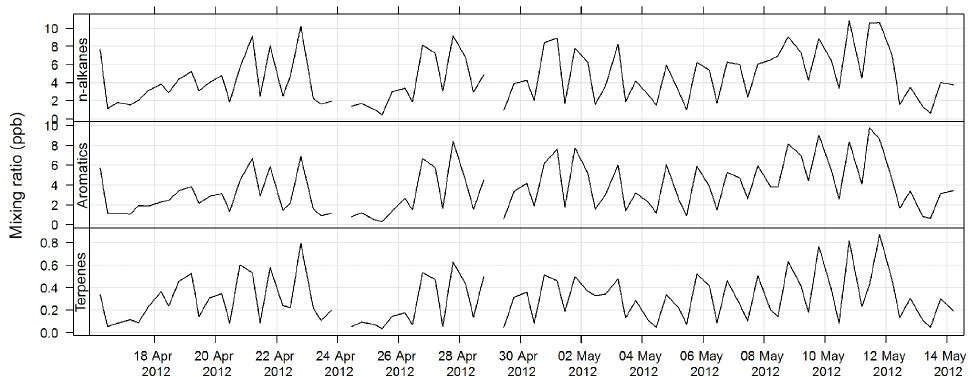
Figure 22. Time series of total alkane, total aromatics, and total terpene mixing ratios during SPS-II in 2012 measured on absorbent tubes.